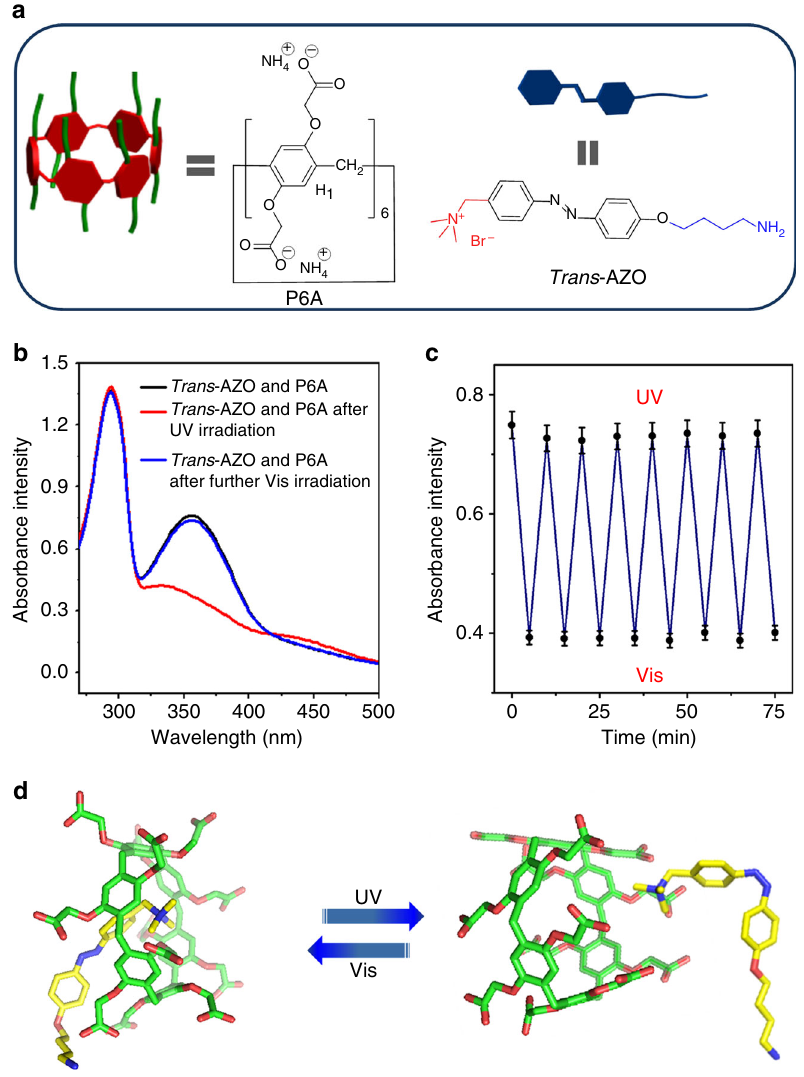
Fig. 2 Host – guest interaction between P6A and AZO. a Schematic of host P6A and guest trans-AZO. b UV-Vis spectra of an equimolar solution of 1.00 × 10 − 4 M AZO and P6A. c Changes in the absorbance at 345 nm of an equimolar solution of P6A and AZO upon alternating irradiation with UV and visible light. d Molecular stimulation of P6A and AZO by irradiation with UV and visible